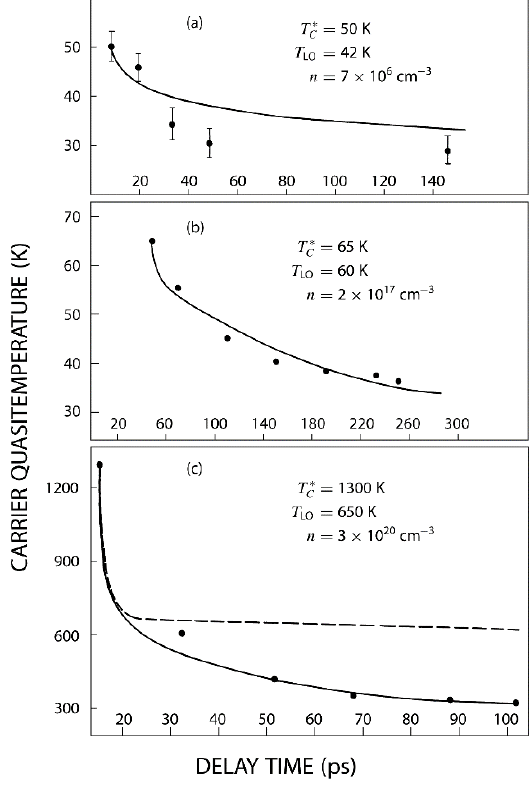
Figure 10. Evolution of the carriers’ quasitemperature in three different experimental situations (indicated in the main text) which are the full lines calculated in NESEF, compared with experimental data (dots) (Sampaio 75